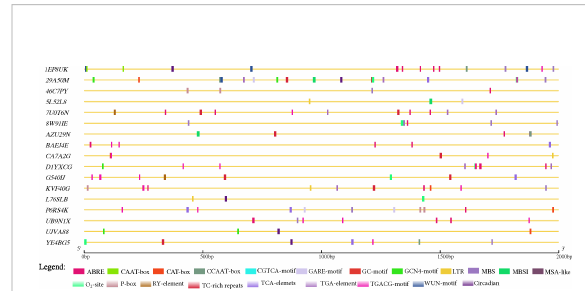
FIGURE 4 Key cis-acting regulatory elements (CAREs) identi fi ed in the promoter regions (2 kbp upstream) of the 17 predicted candidate genes in this study retrieved from PlantCare database (Lescot et al., 2002). ABRE= abscisic acid responsiveness; CAAT-box= essential CARE, CAT-box= CARE related to meristem expression, CCAAT-box= MYBHv1 binding site, GARE-motif= gibberellin- responsive element, GC-motif= anoxic speci fi c inducibility, GCN4- motif= involved in endosperm expression, LTR= low temperature responsiveness, MBS= MYB binding site involved in drought- inducibility, MBSI= MYB binding site involved in fl avonoid biosynthetic genes regulation, MSA-like= cell cycle regulation, O 2 - site= zein metabolism regulation, P-box= gibberellin-responsive element, RY-element= seed-speci fi c regulation, TC-rich repeats= defense and stress responsiveness, TCA-elements= salicylic acid responsiveness, TGA-element= auxin-responsive element, TGACG-motif= MeJA-responsiveness, and, WUN-motif= and Circadian= circadian